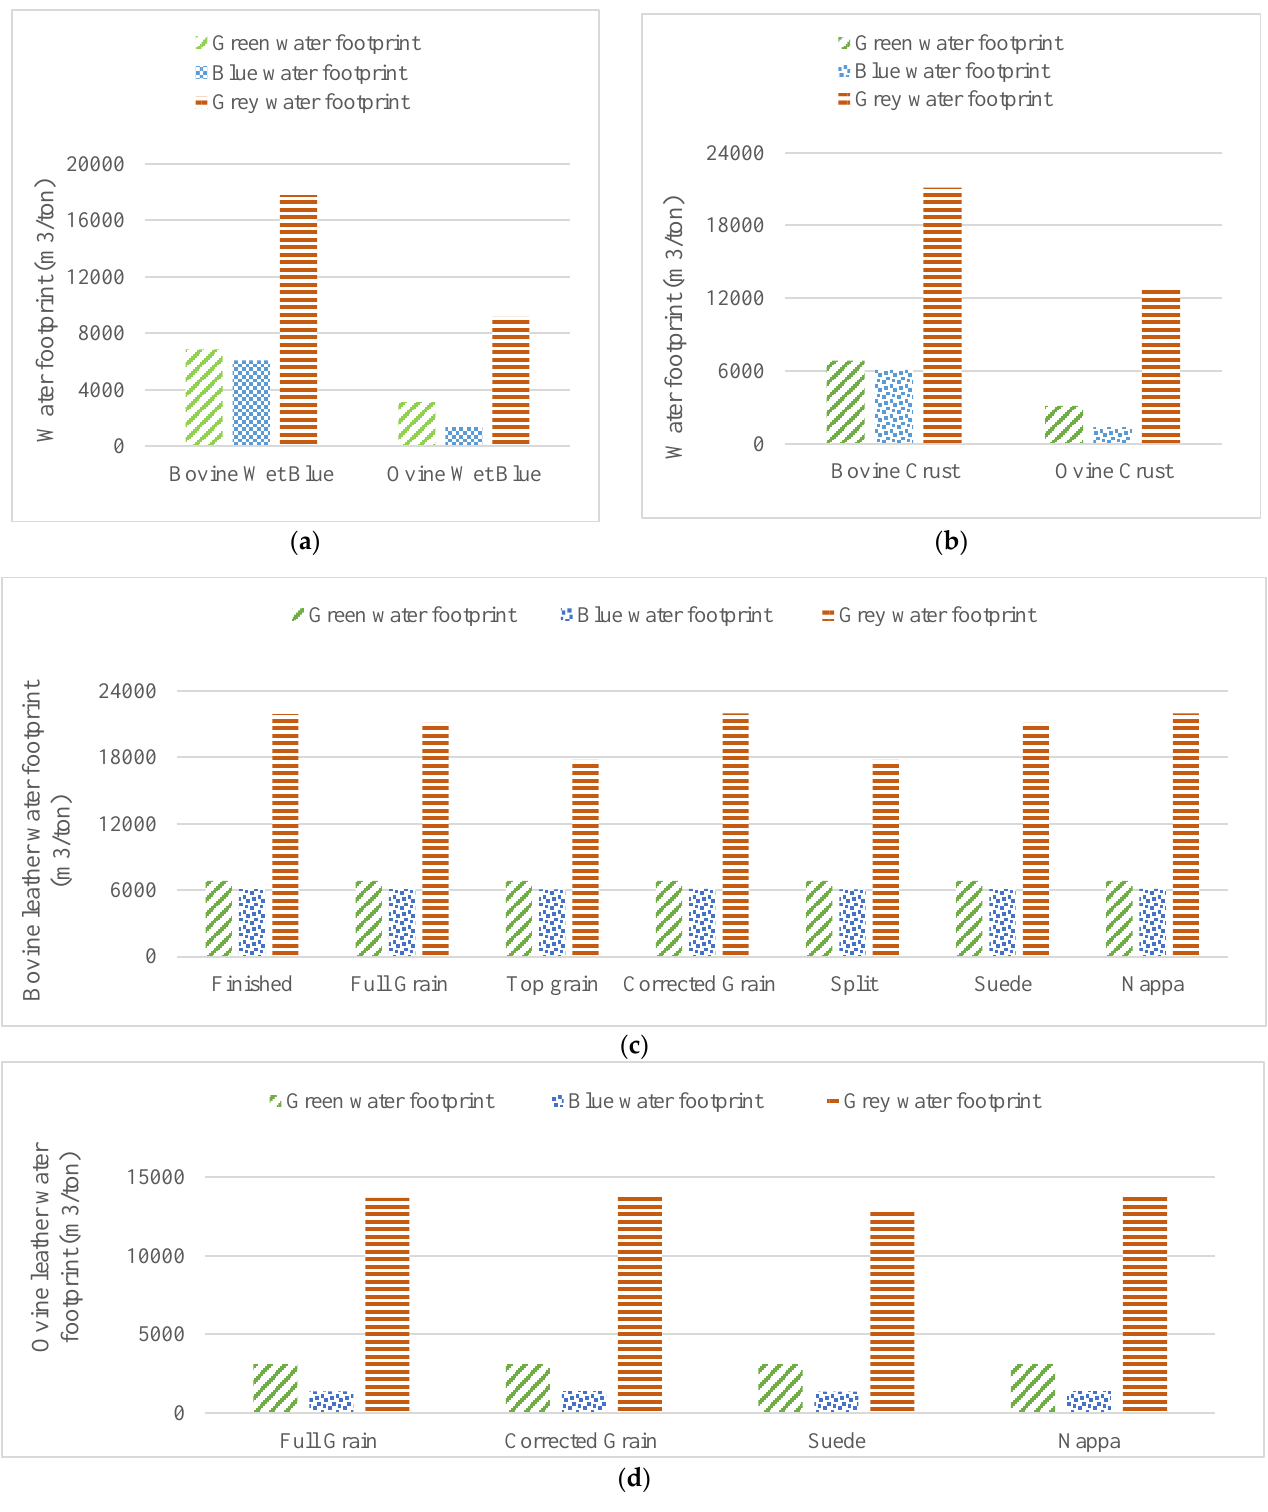
Figure 4. Water footprint (green, blue and grey) of ( a ) wet blue leather and ( b ) crust leather. ( c ) Bovine finished leather and ( d ) ovine finished leather .